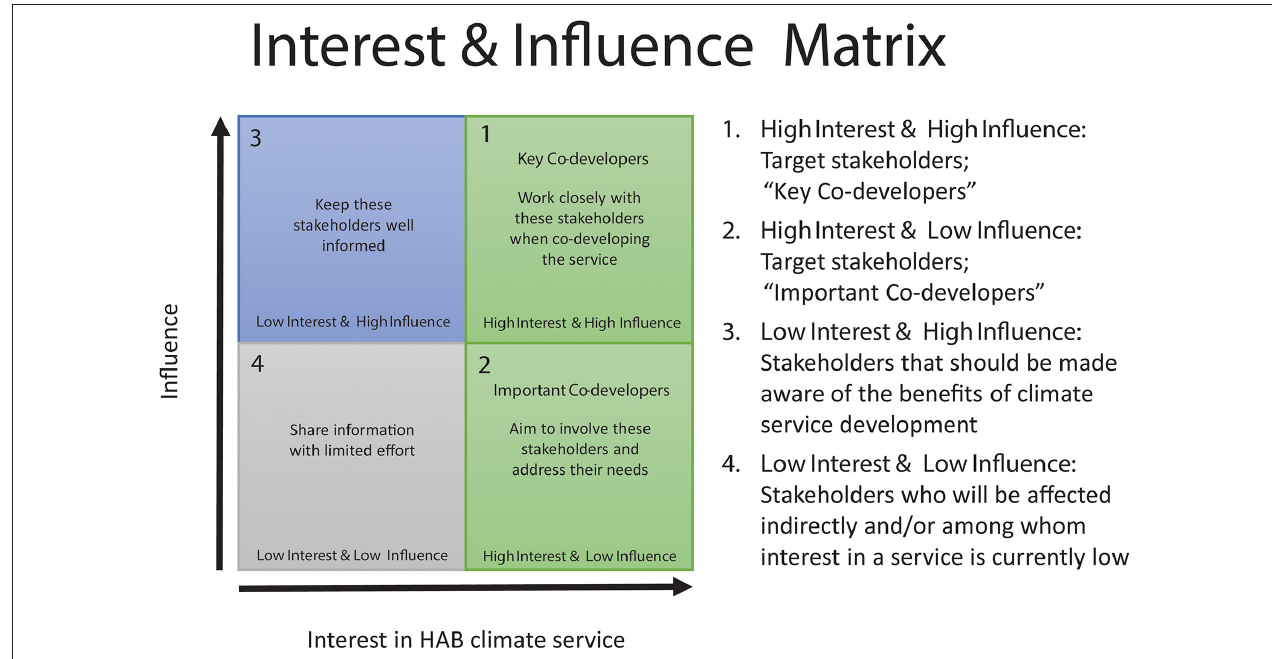
FIGURE 1 | Stakeholder interest-influence matrices were created for each of the case studies. The position of stakeholders in the matrix reflects the identified stakeholder group, their interest in the proposed climate service and their influencing power. Modified version of Mendelow